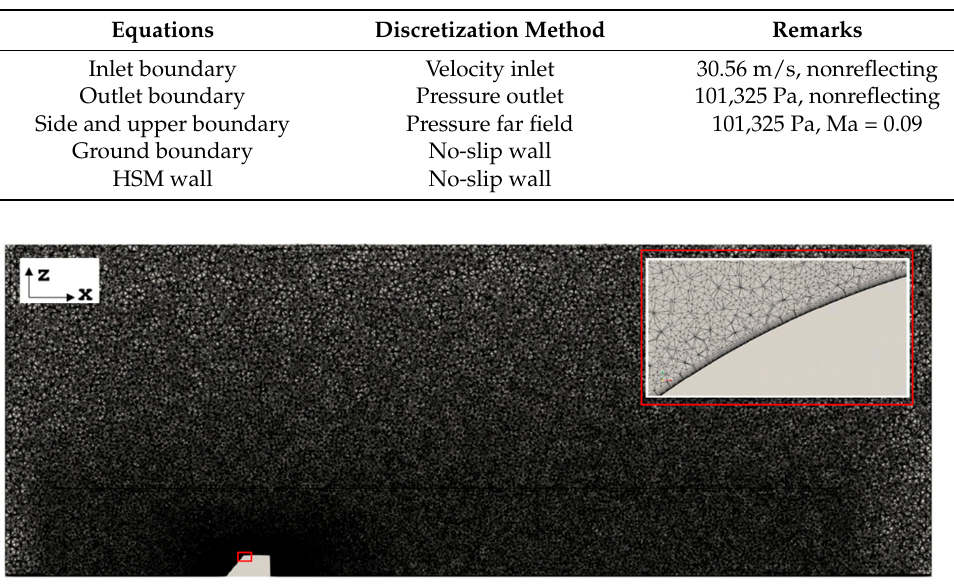
Figure 4. Grid description of computational domain in x – z plane.